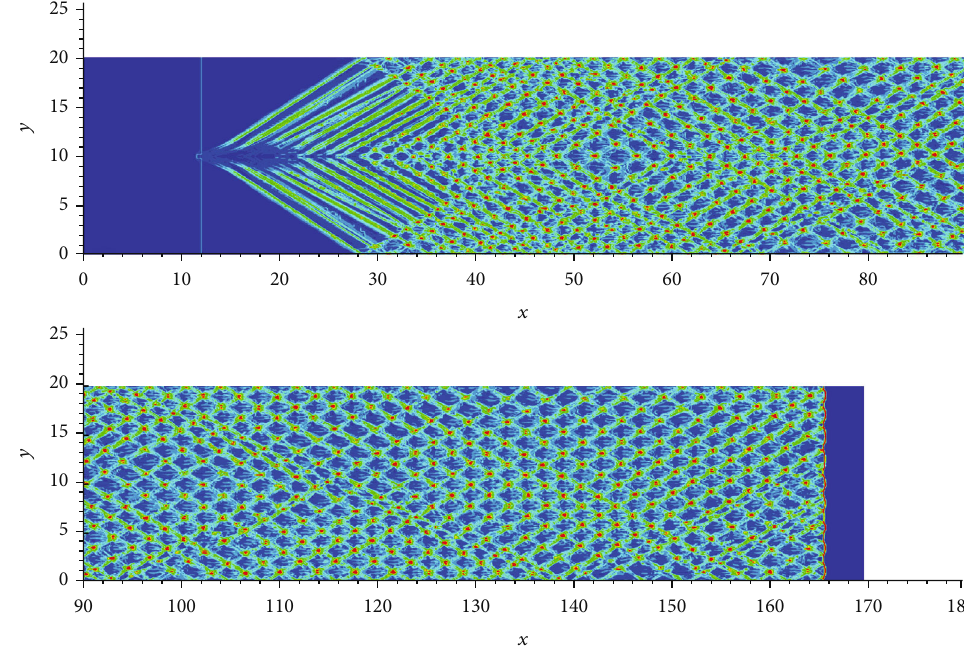
Figure 15: Numerical smoke foil of the normal detonation for the time interval (0,